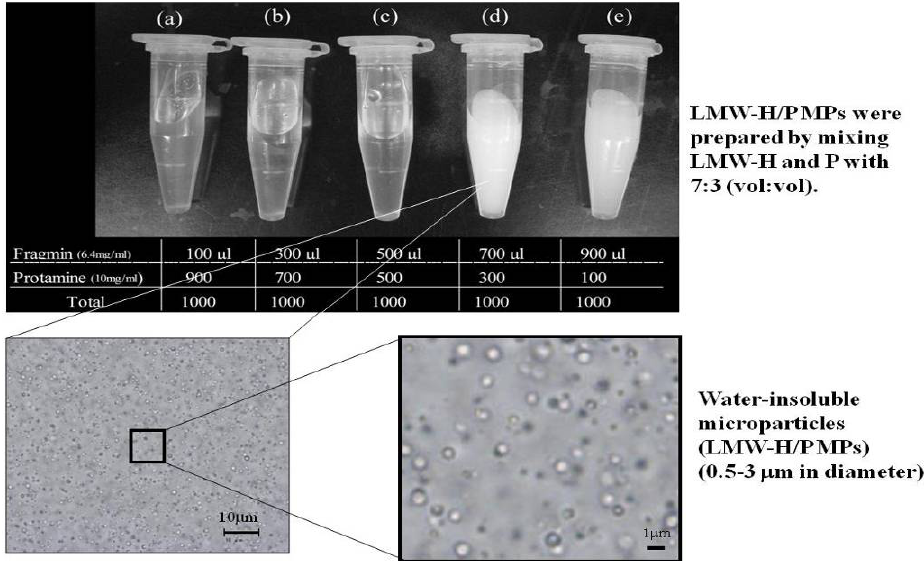
Figure 1. Preparation of Fragmin (LMW-H)/Protamine (P)